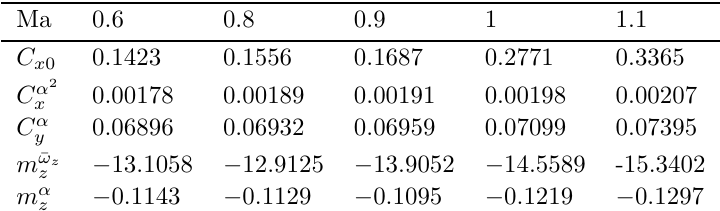
Table 1. Aerodynamic parameters.